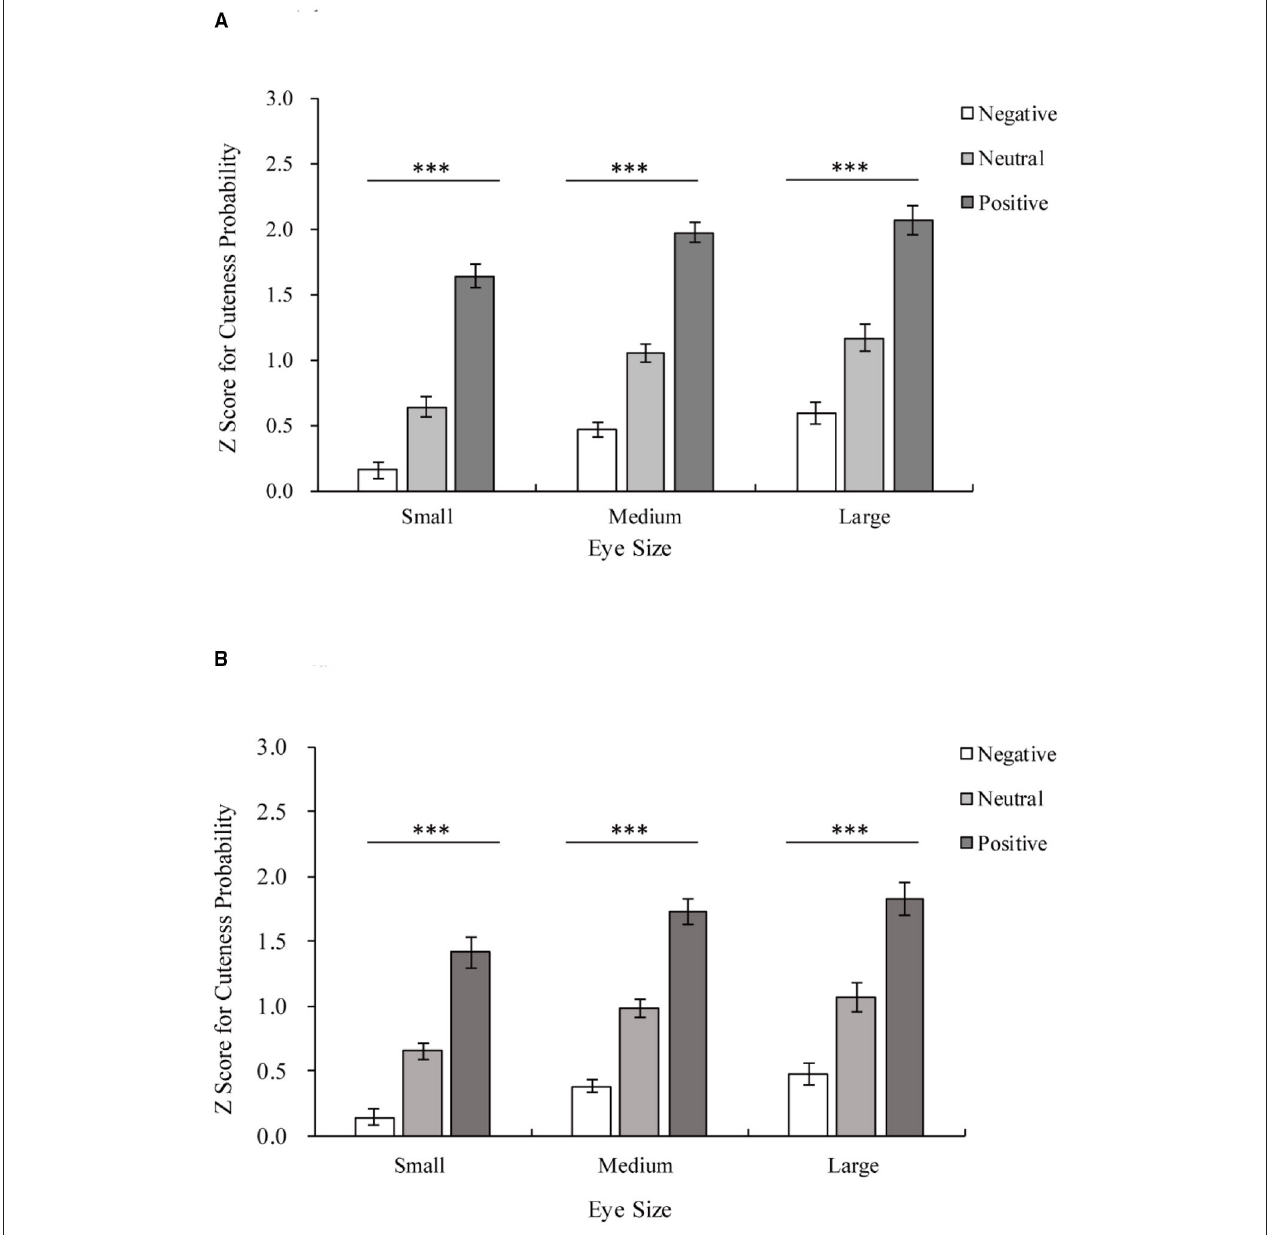
FIGURE 4 | Z scores for the cuteness probability of adults and infants with the same eye size. The horizontal axis shows three levels of eye size, and the Z score for cuteness probability is shown on the vertical axis. White indicates negative stimuli, gray indicates neutral stimuli, and dark gray indicates positive stimuli. (A) The results of the adult group. Positive > Neutral > Negative among stimuli with the same eye size, all *** p < 0.001. (B) The results of the infant group. Positive > Neutral > Negative among stimuli with the same eye size, all *** p < 0.001.